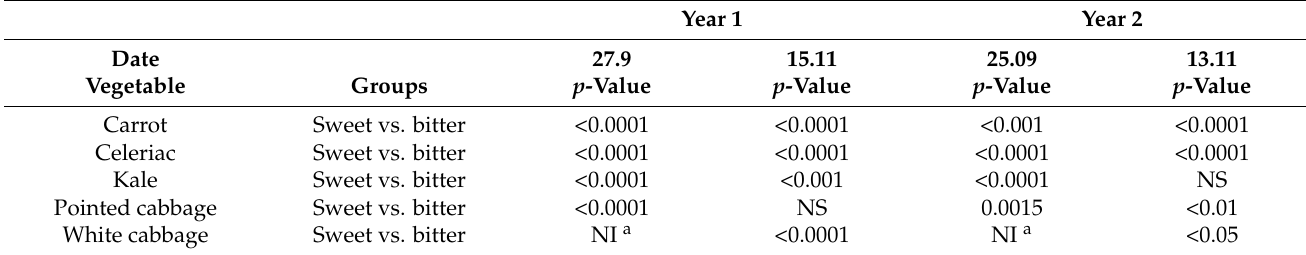
Determination of sweet vs. bitter sensory characteristics of vegetable cultivars used in the study by a professional sensory panel. Significant p value denotes a significant difference between the panels’ assessment of the bitter and sweet characteristics of the respective paired sweet and bitter cultivars. a NI = Not